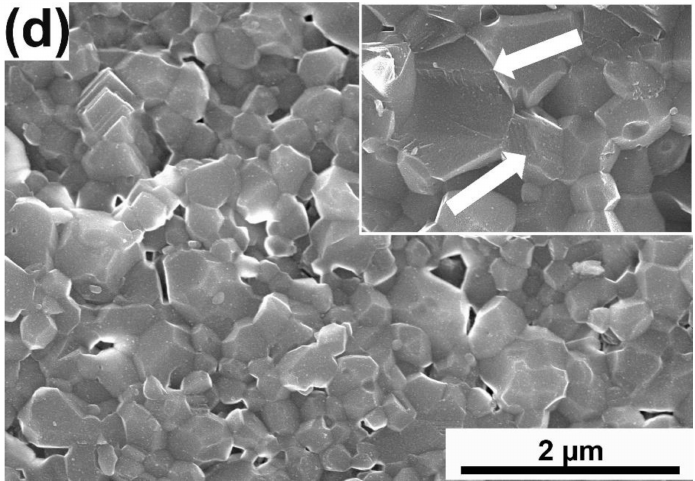
Figure 3. The fracture surface of ( a ) Al 2 O 3 , ( b ) Al 2 O 3 —10 wt% of Ti 3 AlC 2 from horizontal mill, ( c ) Al 2 O 3 —10 wt% of Ti 3 AlC 2 from Atrittor mill, ( d ) Al 2 O 3 —10 wt% of Ti 3 AlC 2 from planetary mill (the arrows mark areas with a variable fracture mechanism).